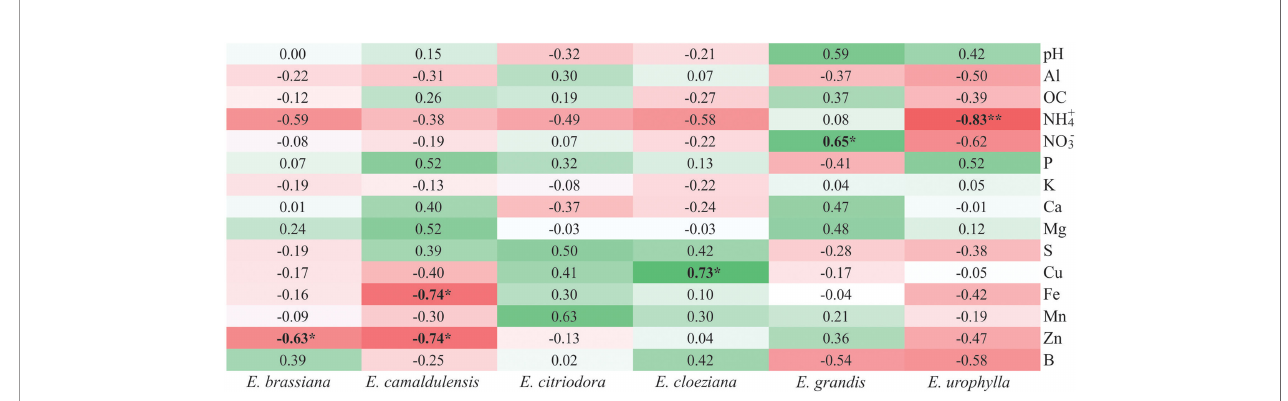
FIGURE 5 | Heatmap considering Spearman ’ s rank correlation coef fi cient between soil fungal community structure and soil chemical attributes in different Eucalyptus species. Red color indicates a negative correlation while the green color indicates a positive correlation. The intensity of the colors indicates the strength of the correlations. *p < 0.05, **p